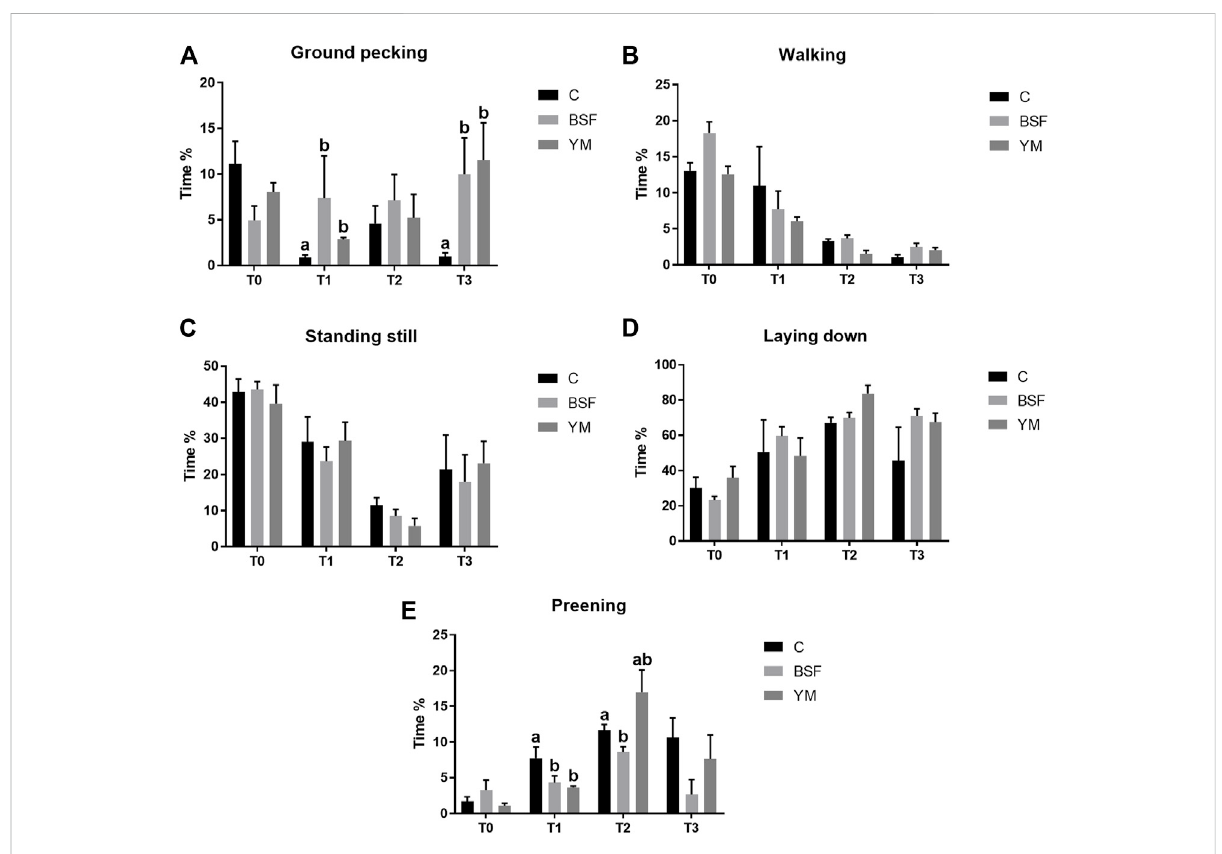
FIGURE 4 Duration behaviours of the broiler chickens in the morning (diet*time interaction). (A) Preening. (B) Allopreening. (C) Stretching. (D) Wing fl apping. (E) Shaking. Graph bars (representing least square means) with different superscript letters (a, b) indicate signi fi cant differences among the experimentaltreatmentswithintheexperimentaltimes.C=controlgroup;BSF=Cdiet+blacksoldier fl ylivelarvae;YM=Cdiet+yellowmealworm live larvae. T0 = day 0; T1 = day 11; T2 = day 22; T3 = day